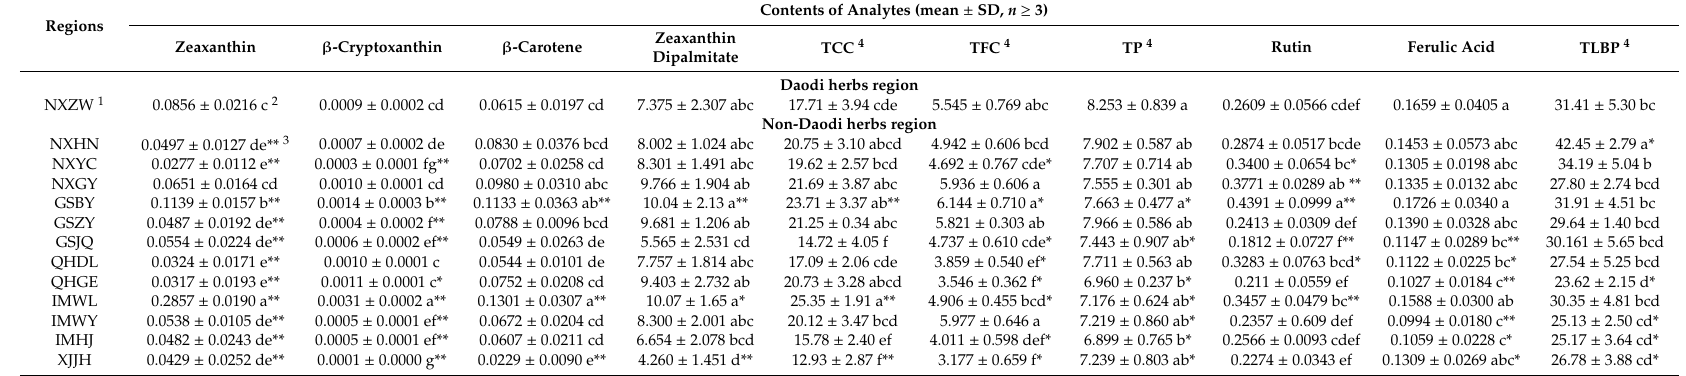
Table 1. Functional component contents (mg / g DW) of fruit of Lycium barbarum from di ff erent regions.